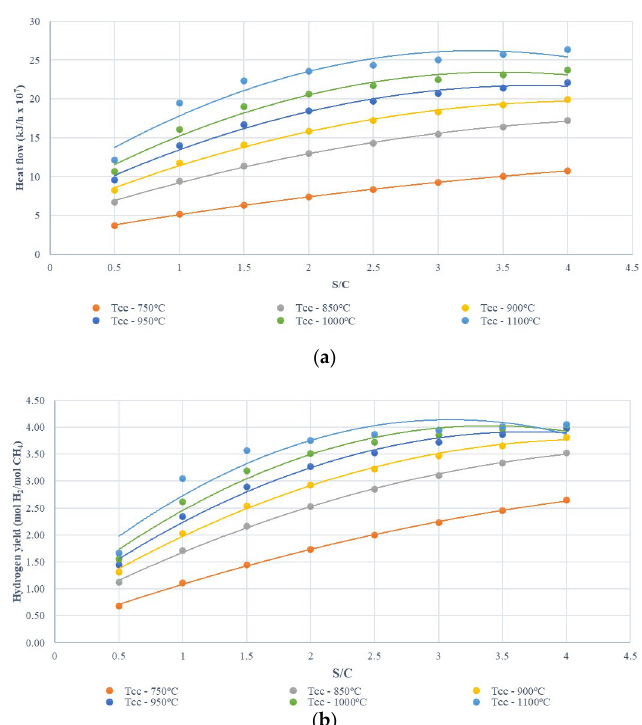
Figure 2. Comparison of different steam-to-carbon (S/C) molar ratios at different temperatures ( T cc ) for ( a ) heat requirements (kJ/h) and ( b ) hydrogen yield (mol H 2 /mol CH 4 ) at the REF block.